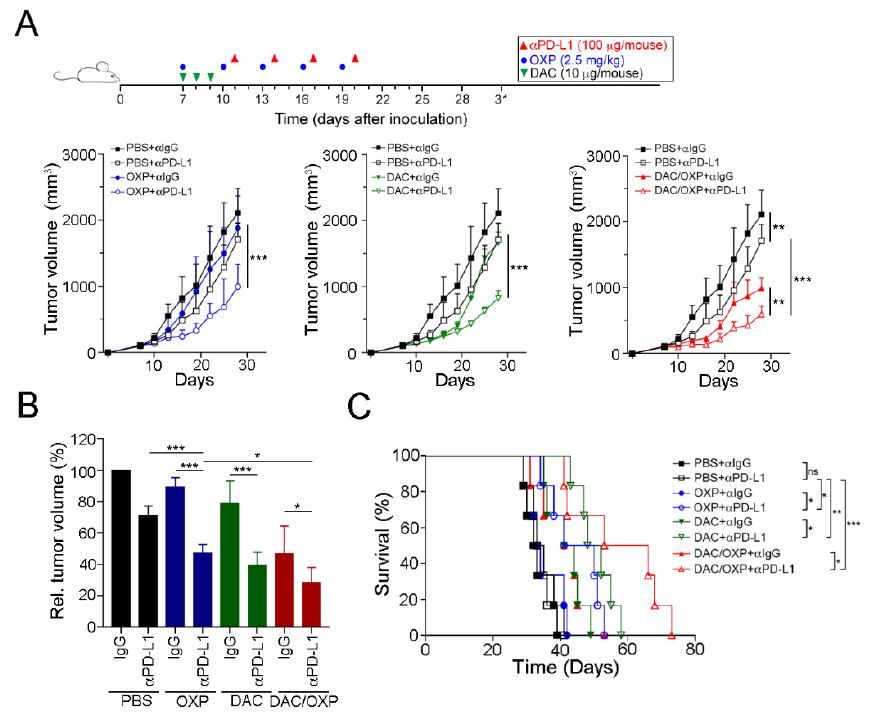
Figure 6. Decitabine enhanced the therapeutic efficacy of anti-PD-L1 therapy in CRC in vivo. ( A ) Tumor-bearing BALB / c mice ( n = 6) were treated with OXP (2.5 mg / kg, i.p. injection), decitabine (DAC, 10 µ g / mouse, i.p. injection) and the PD-L1 blockade (100 µ g / mouse, i.p. injection) at the indicated times shown on the timeline. Tumor volume was measured and calculated every 3 days. The results of the OXP and DAC alone groups are displayed in Figure S3. The quantification of these results is shown ( n = 6); ** p < 0.01 and *** p < 0.001. ( B ) Relative tumor volume was calculated. The quantification of these results is shown ( n = 6); * p < 0.05 and *** p < 0.001. ( C ) Mouse survival was assessed with Kaplan–Meier survival curves ( n = 6); * p < 0.05, p < 0.01 and *** p <